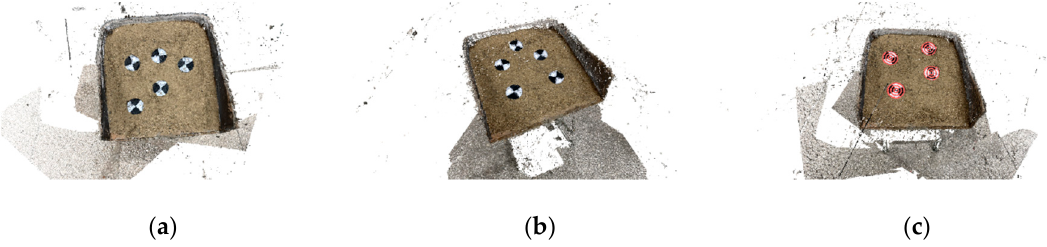
Figure 9. Results of A-SfM reconstruction in experiment 2: ( a ) the photograph distance was 2 m, and the mark points were common; ( b ) the photograph distance was 1 m, and the mark points were common; ( c ) the photograph distance was 1 m, and the mark points were concentric.